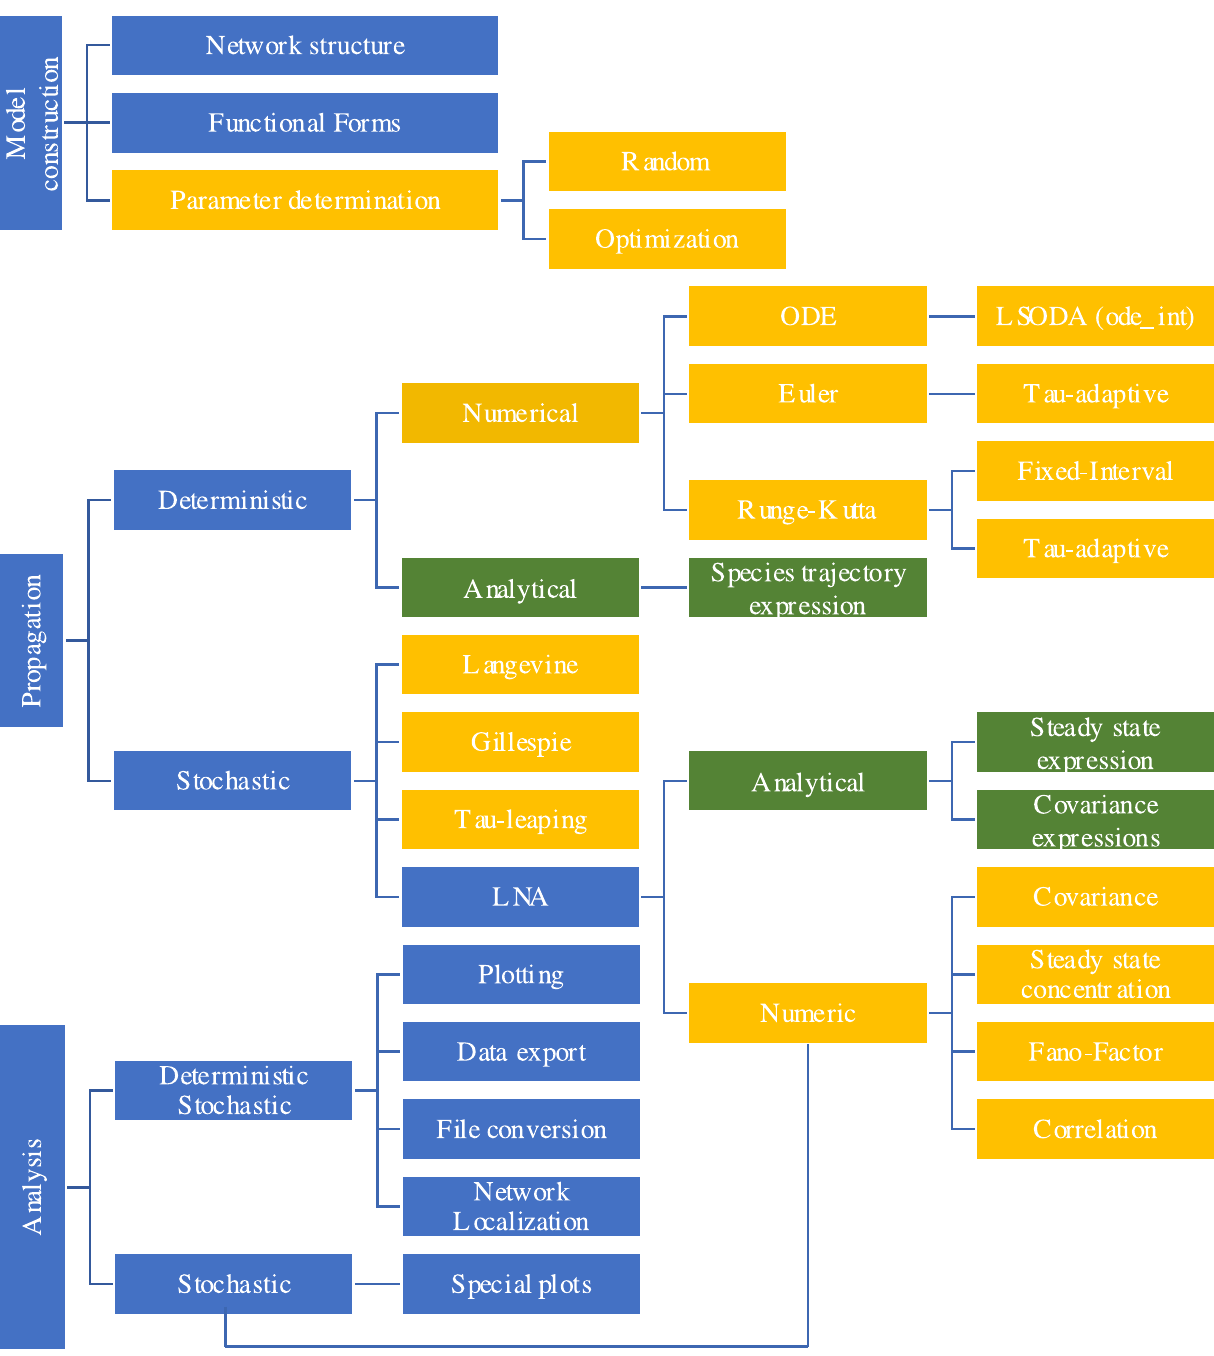
Fig 1. Schematic diagram showing some of the modeling tasks available in BioSANS. The basic modeling scheme includes model construction, propagation, and analysis. Except for blue colors, the same color in different branches indicates similar types of analysis under a common category. Green shaded boxes are for analytical expressions, and orange shaded boxes are for numerical